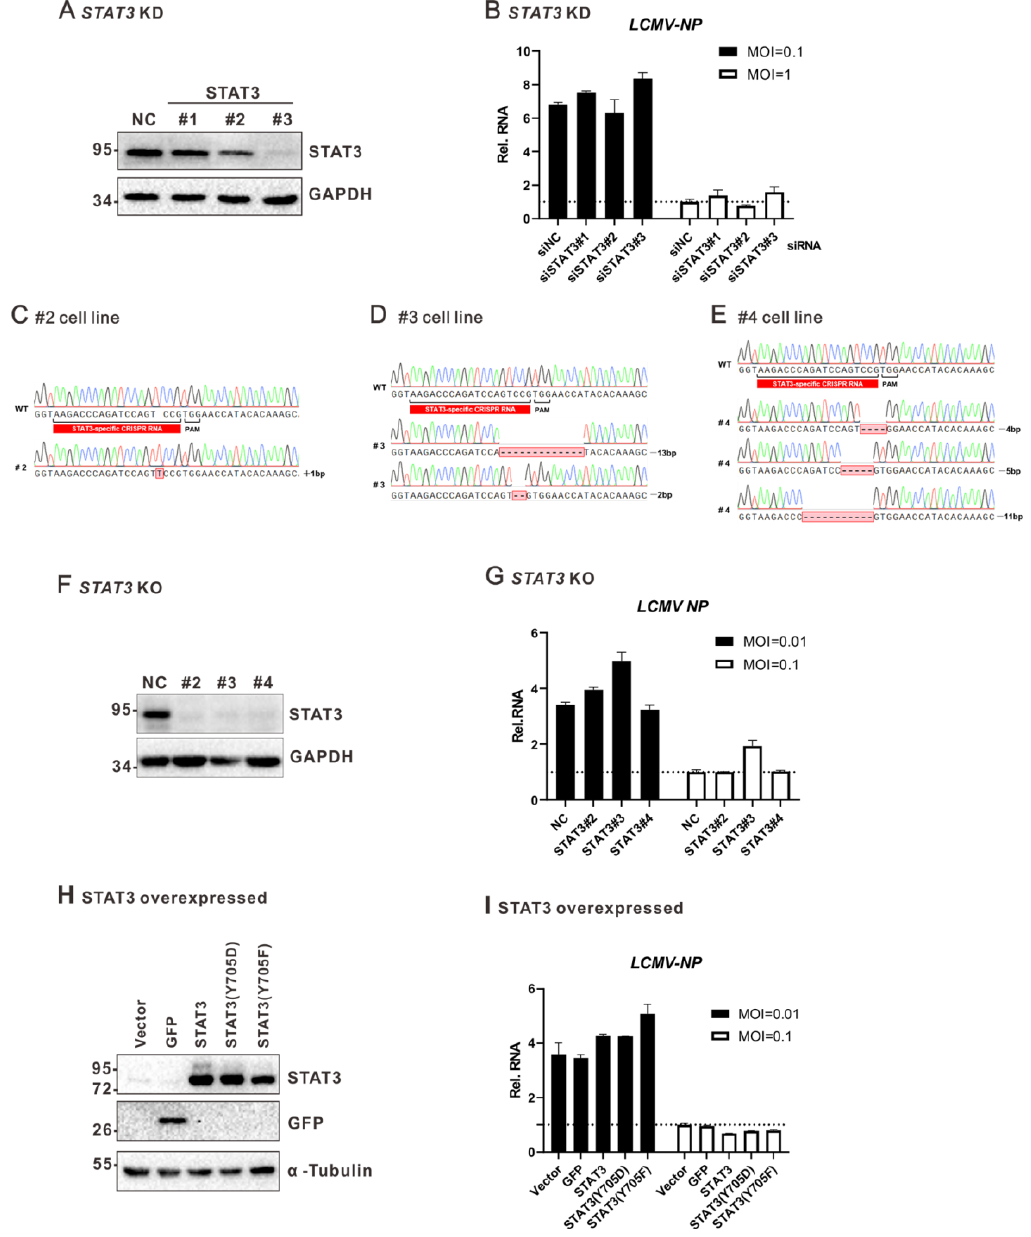
Figure 6. STAT3 does not affect LCMV multiplication in A549 cells. ( A ) RNAi-based knockdown of STAT3 in A549 cells. ( B ) The effect of the knockdown of STAT3 on LCMV multiplication. STAT3-knockdown A549 cells were infected with LCMV at an MOI of 0.1 or 1. At 24 h post infection, cells were collected and the intracellular level of LCMV RNA was measured with qRT-PCR using primers targeting the NP ORF sequence. Intracellular levels of GAPDH mRNA were used as the endogenous control. ( C – E ) Sanger sequencing analysis of three CRISPR/Cas9-based STAT3-knockout cell lines. ( F ) Immunoblotting analysis of intracellular STAT3 protein level in STAT3-knockout A549 cells. ( G ) The effect of the knockout of STAT3 on LCMV multiplication. STAT3-knockout A549 cells were infected with LCMV at an MOI of 0.01 or 0.1. At 48 h post infection, cells were collected and the intracellular level of LCMV RNA was measured with qRT-PCR. Intracellular levels of GAPDH mRNA were used as the endogenous control. ( H ) Immunoblotting analysis of STAT3 protein level in cells overexpressing STAT3, STAT3 Y705D, or STAT3 Y705F. ( I ) The effect of the overexpression of STAT3, STAT3 Y705D, or STAT3 Y705F on LCMV multiplication. Cells overexpressing STAT3, STAT3 Y705F, or STAT3 Y705D were infected with LCMV at an MOI of 0.01 or 0.1. At 48 h post infection, cells were collected and the intracellular level of LCMV RNA was